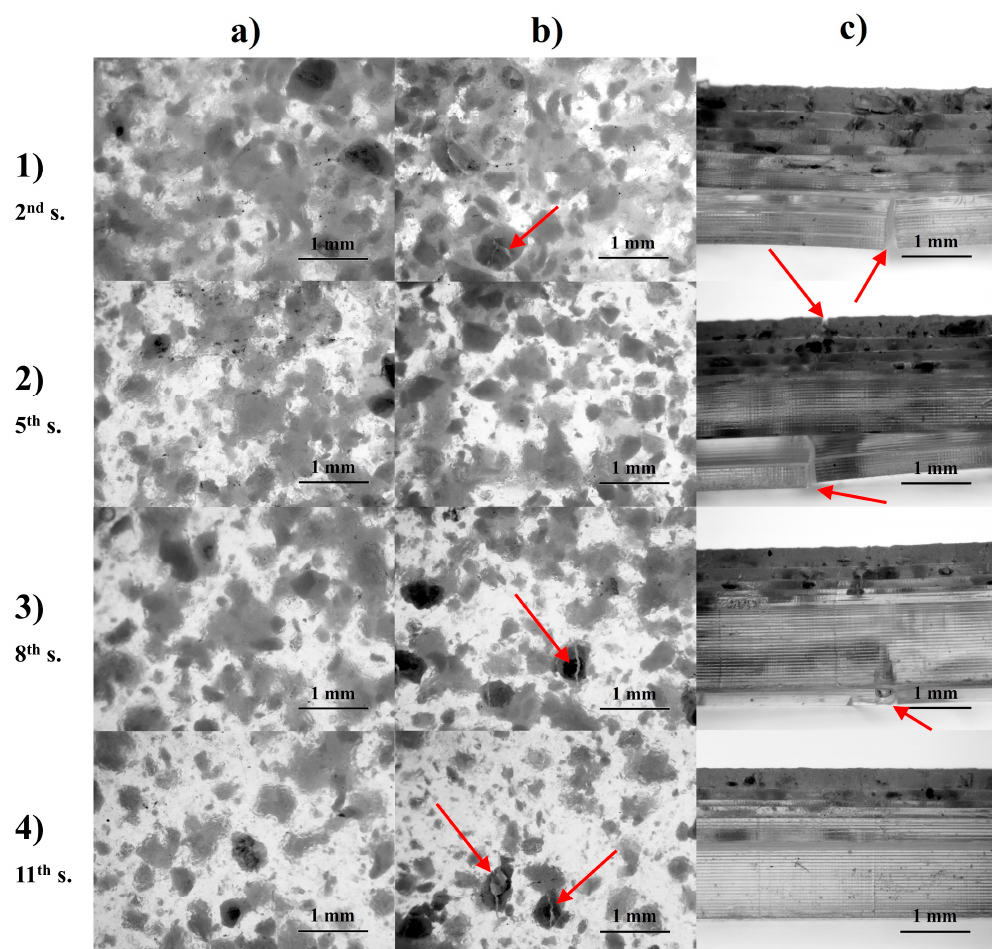
Figure 4. Images of the 2nd, 5th, 8th, and 11th composite sample ( a ) surfaces before releasing, ( b ) surfaces after releasing, and ( c ) sides after releasing. Red arrows indicate cracks.